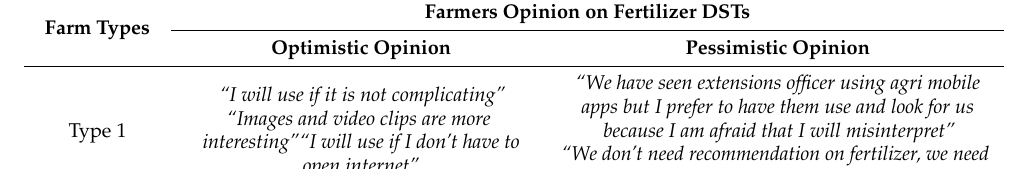
Table 9. Farmers’ opinions on fertilizer